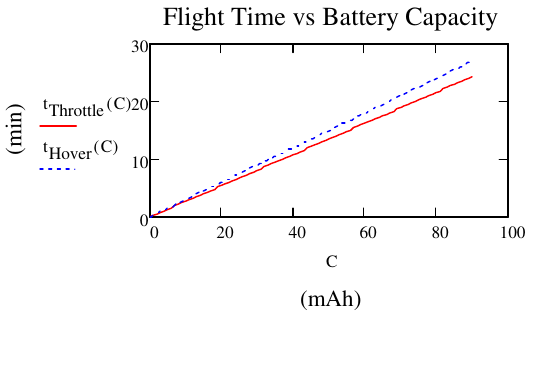
Table 4: Summaries of values used in (7) to calculate the maximum range of NAV.